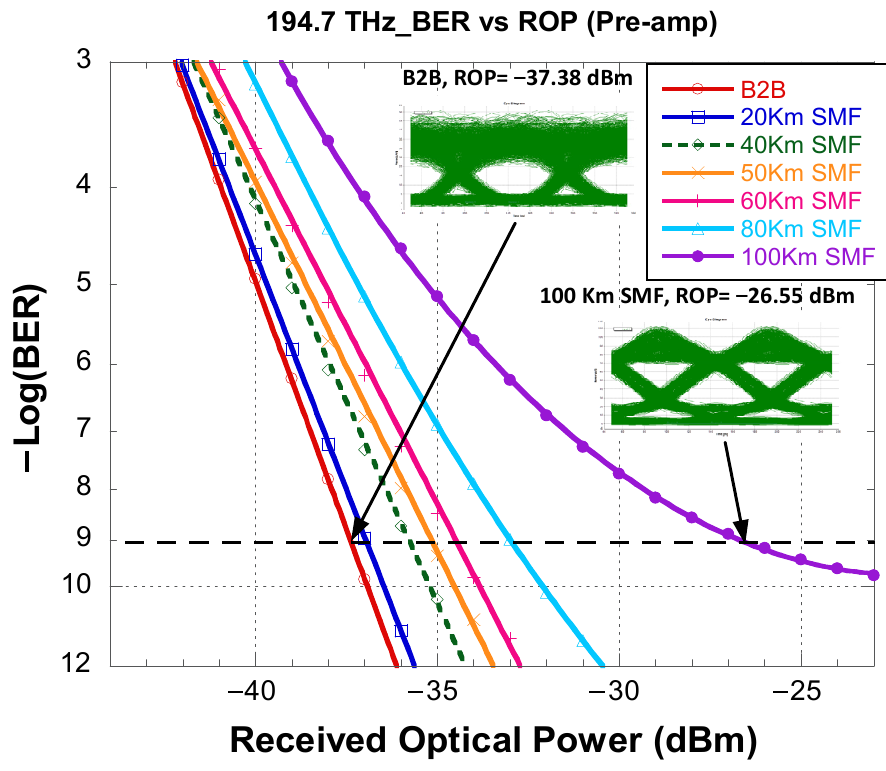
Figure 21. BER curve of CH40 (194.7 THz).